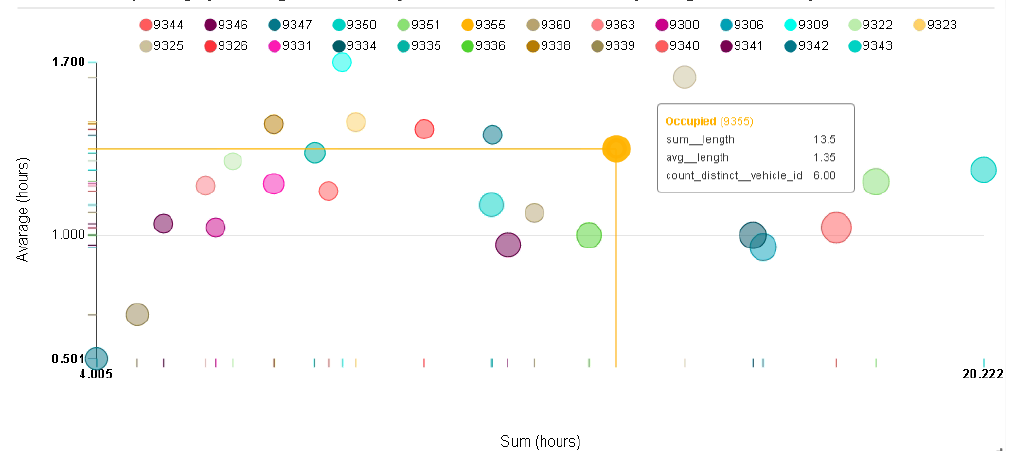
Figure 10. Parking usage pattern of the 25 most used parking spots.